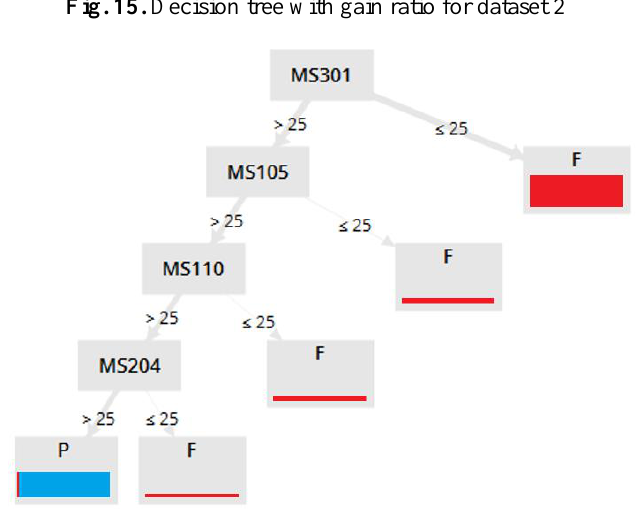
Fig. 16. Decision Tree with Gini Index for Dataset 2 The best rules extracted from rule induction with information gain for both datasets are shown in Tables 14 and 15.